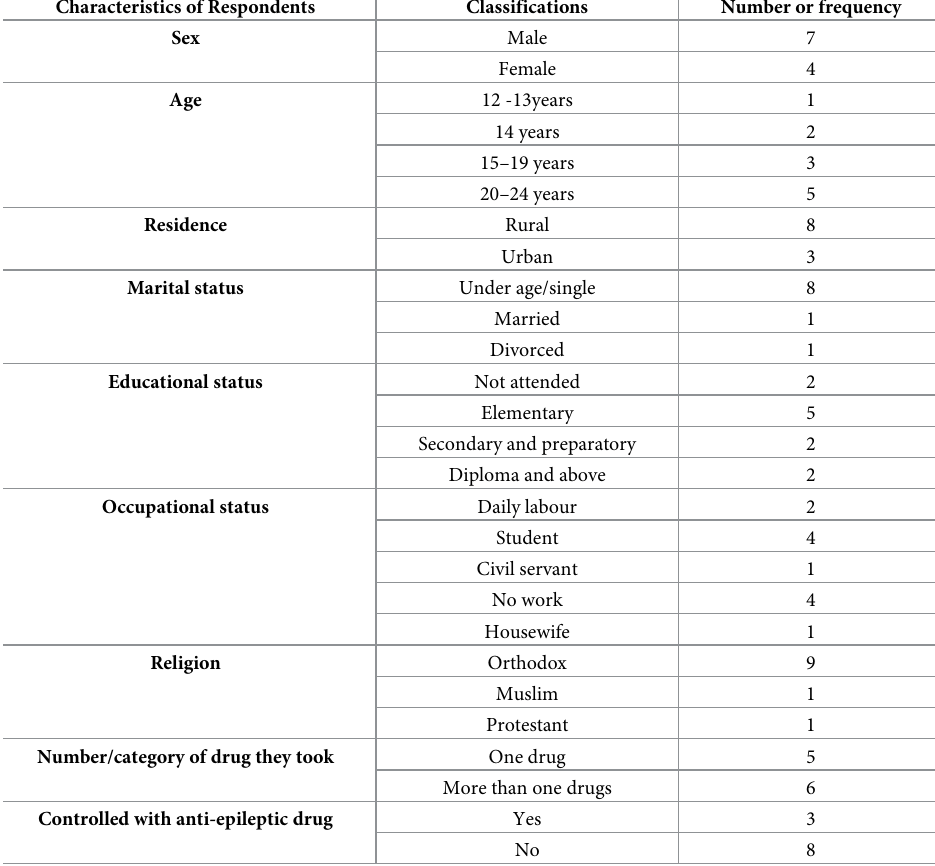
Table 1. Socio-demographic characteristics of study participants among three government referral hospitals in Bahir Dar city, Ethiopia, 2021. Characteristics of